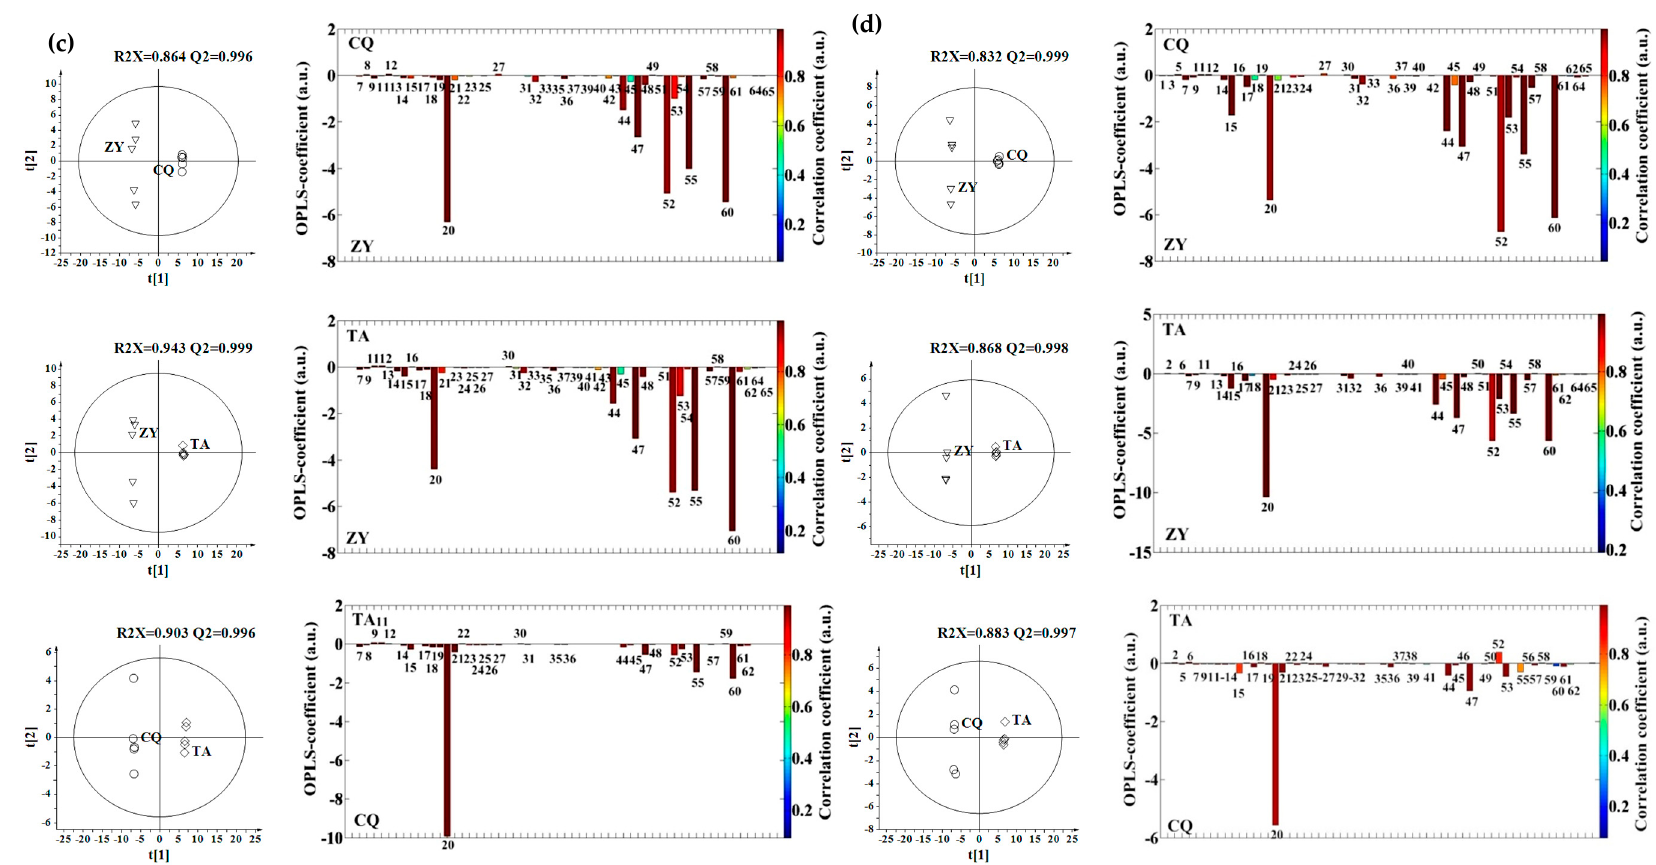
Figure 2. OPLS-DA scores plots ( left ) and coefficient-coded loadings plots ( right ) deriver from LC-MS data for S. miltiorrhiza extracts obtained from three different locations (ZY, Zhuyang; CQ, Changqing; TA, Taian) for each genotype (( a ) Genotype 1; ( b ) Genotype 2; ( c ) Genotype 3; and ( d ) Genotype 4): 7, Salvianolic acid F; 13, Salvianolic acid І ; 14, Salvianolic acid E; 15, Rosmarinic acid; 17, Lithospermic acid; 18, Prolithospermic acid derivative; 20, Salvianolic acid B; 32, Tanshinone ІІ B; 36, Trijuganone C; 44, 15,16 ′ -dihydrotanshinone І ; 47, Methyltanshinonate; 48, Trijuganone B; 52, Cryptotanshinone; 53, Tanshinone І ; 55, 1,2 ′ -dihydrotanshinone І ; and 60, Tanshinone ІІ A.